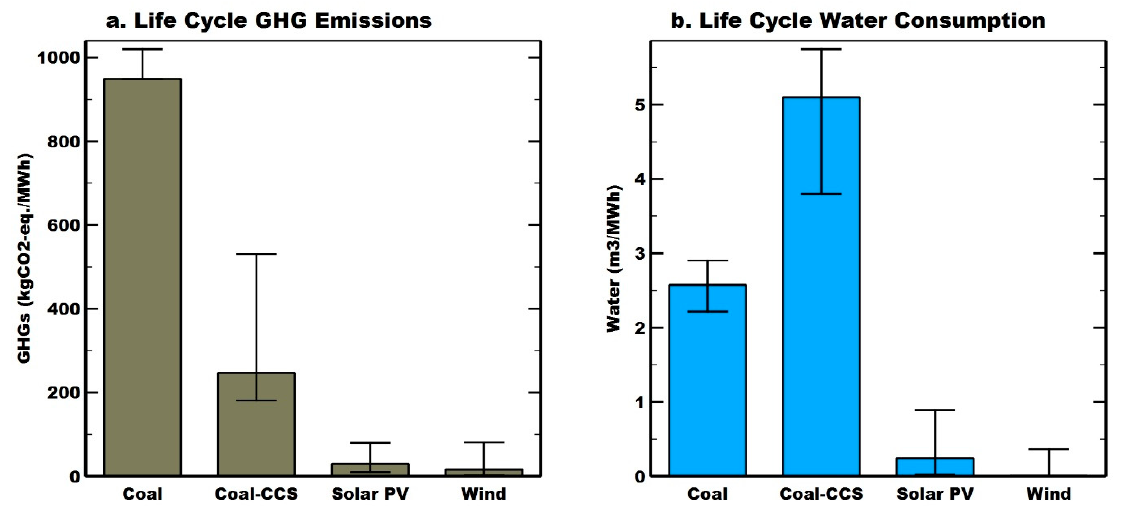
Figure 5. ( a ) Life cycle GHG emissions and ( b ) Life cycle water consumption of coal, coal-CCS, solar PV and wind to generate 1 MWh of electricity.